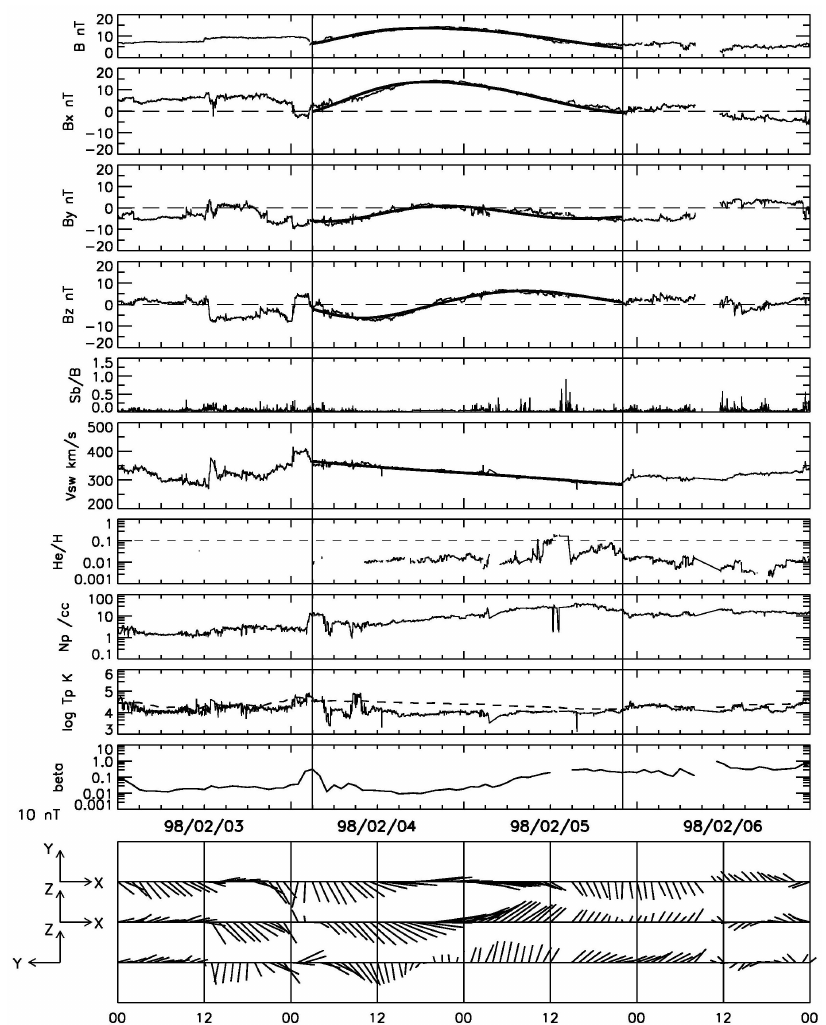
Fig. 2. Results of the torus fitting to the magnetic cloud (Event No. 6), encountered on 4 February 1998 (solid curves), are superimposed on the data plots of the observed solar wind parameters. The two vertical solid lines indicate the MC boundaries. The bottom three panels show the projected magnetic field vectors.